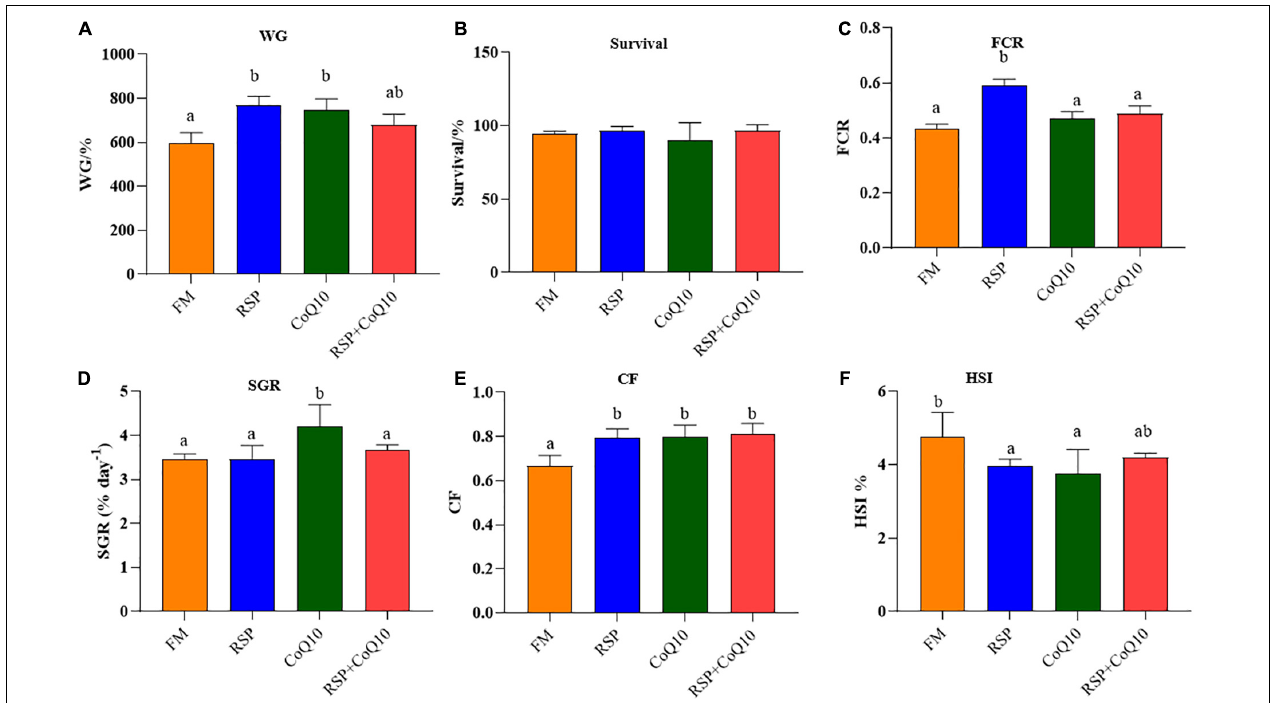
FIGURE 1 | The effect of four different diet treatments on growth performance of shrimp. (A) WG of shrimp in different diet treatments. (B) Survival rates of shrimp in different diet treatments. (C) FCR of shrimp in different diet treatments. (D) SGR of shrimp in different diet treatments. (E) CF of shrimp in different diet treatments. (F) HSI of shrimp in different diet treatments. WG, weigh gain; FCR, feed conversion ratio; SGR, specific growth rate; CF, condition factor; HSI, hepatosomatic index.